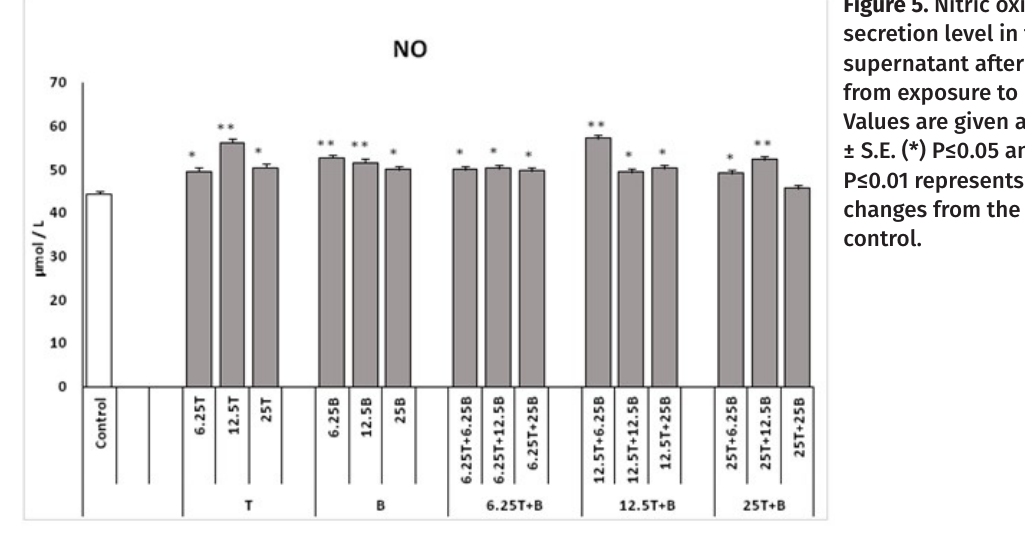
Figure 5. Nitric oxide secretion level in the supernatant after 48 h from exposure to LNA ASOs. Values are given as mean ± S.E. (*) P≤0.05 and (**) P≤0.01 represents significant changes from the negative